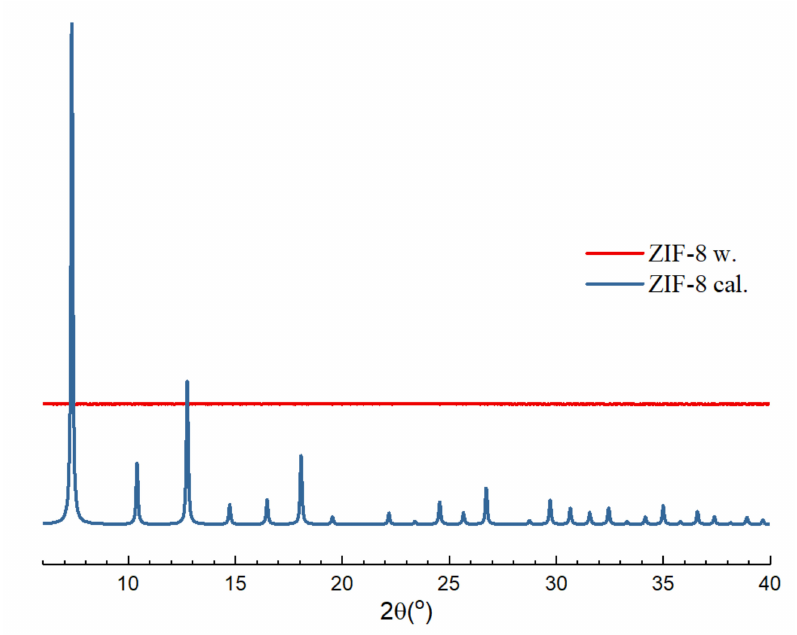
Figure 4. Powder x-ray di ff ractometer (PXRD) pattern of ZIF-8 after water immersion (ZIF-8 w) in comparison with the as synthesized ZIF-8.